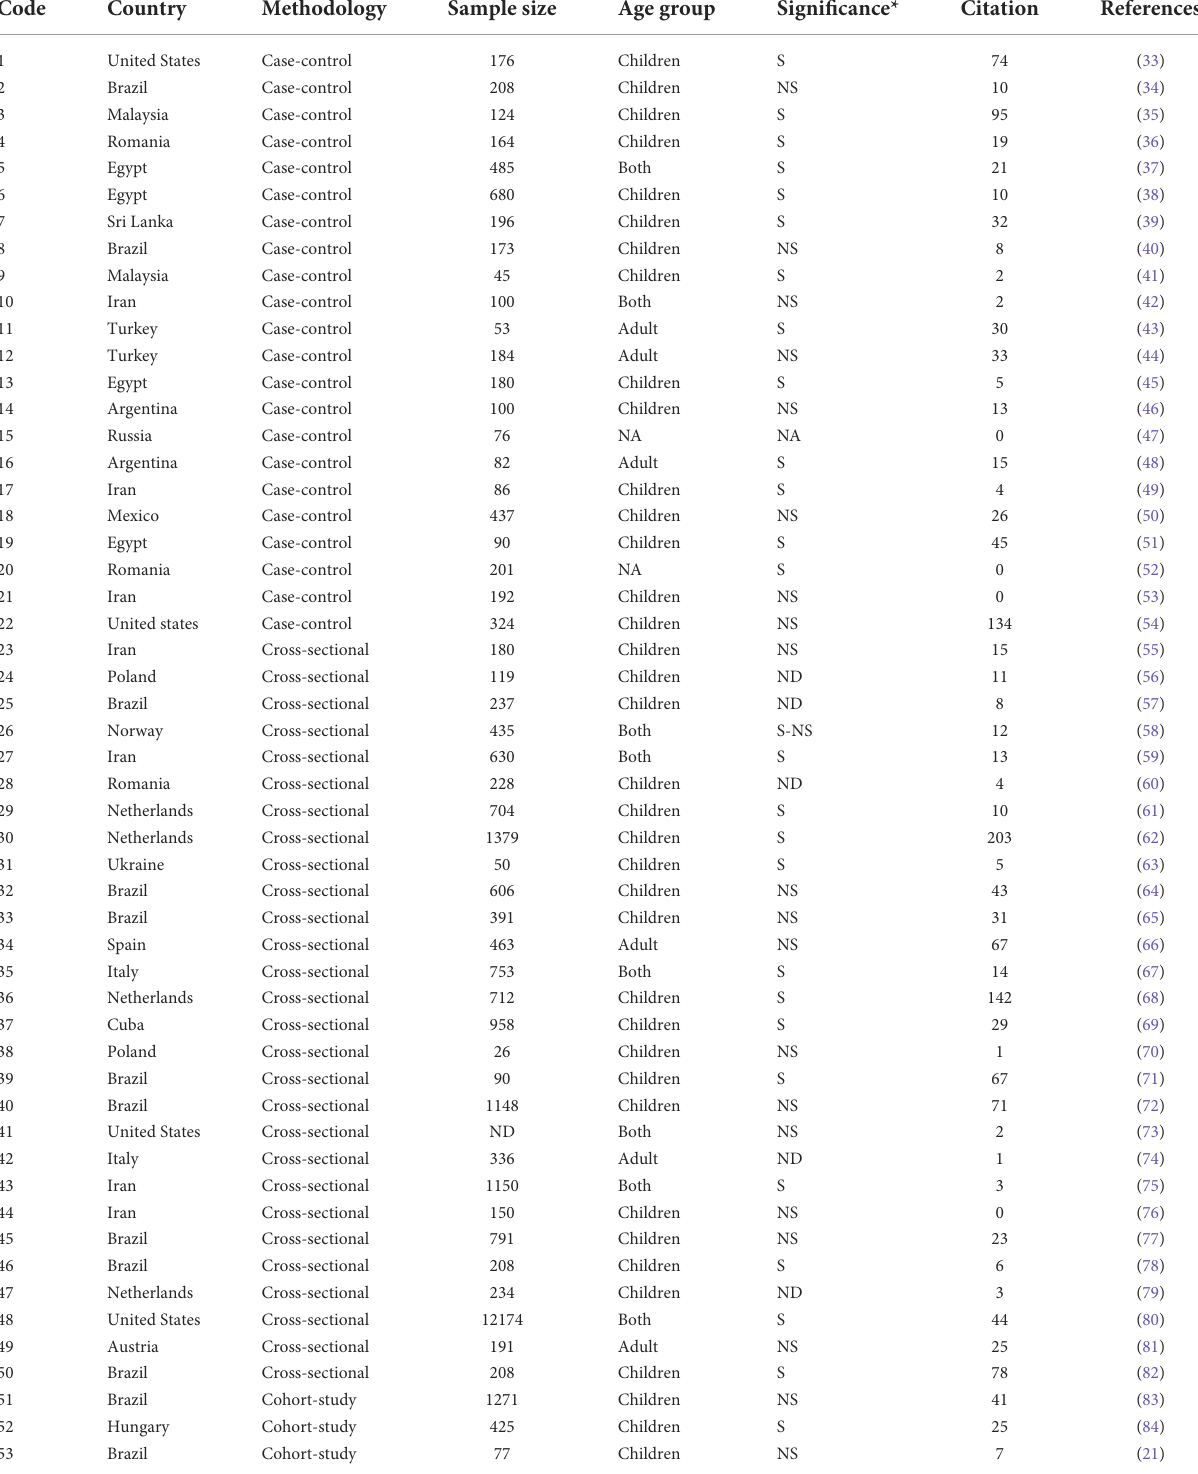
TABLE 4 Summary of the analytical studies published on the asthma- Toxocara association according to different article features.